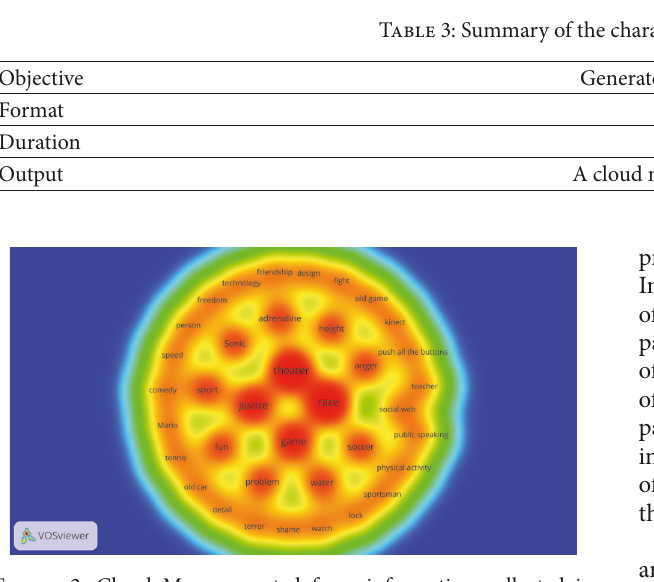
Figure 2: Cloud Map generated from information collected in Session1.Themostrelevantwordsarehighlightedandlocatedcloser to words related to